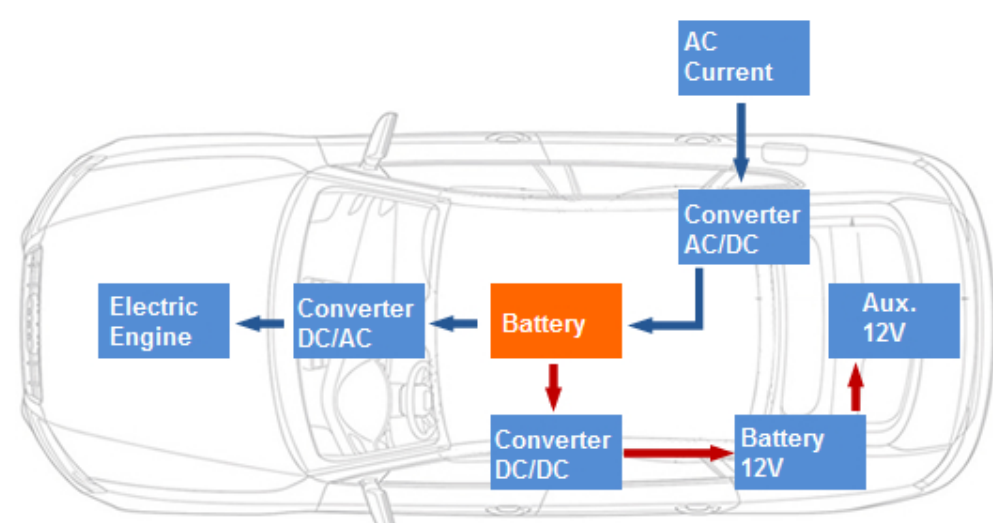
Figure 4. Electric vehicle